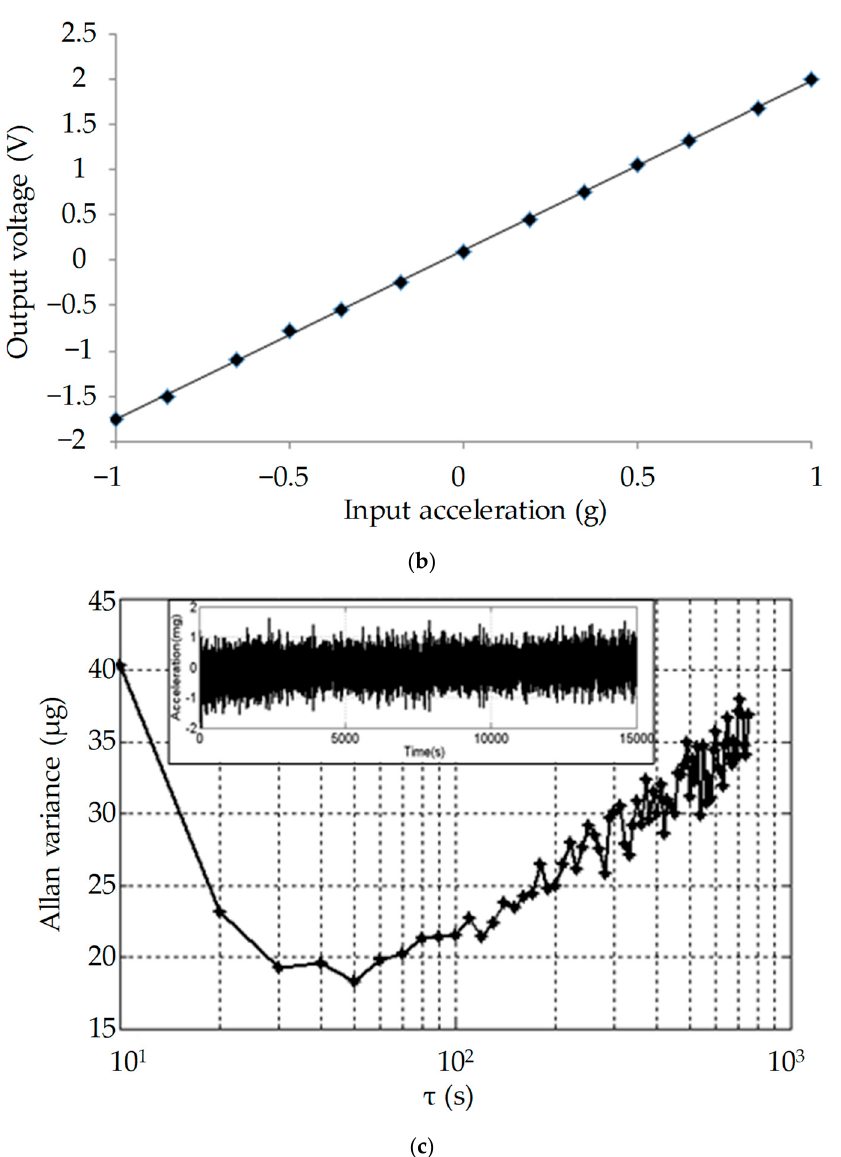
Figure 10. ( a ) The power spectrum density test of the digital accelerometer system; ( b ) the test of nonlinearity; ( c ) the test of bias stability.